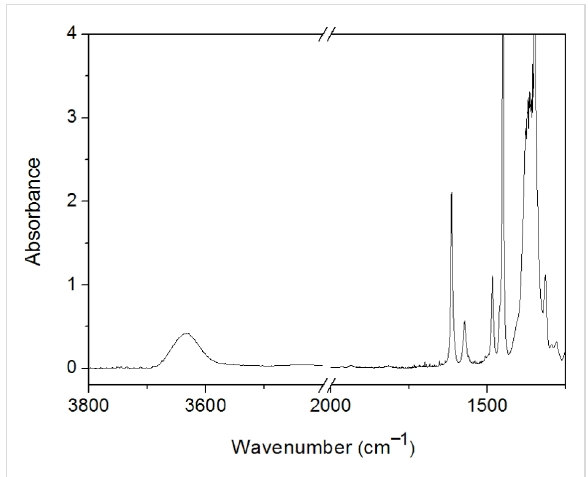
Figure 4: Infrared spectrum of 2-fluorophenylboronic acid in 0.1 M chloroform